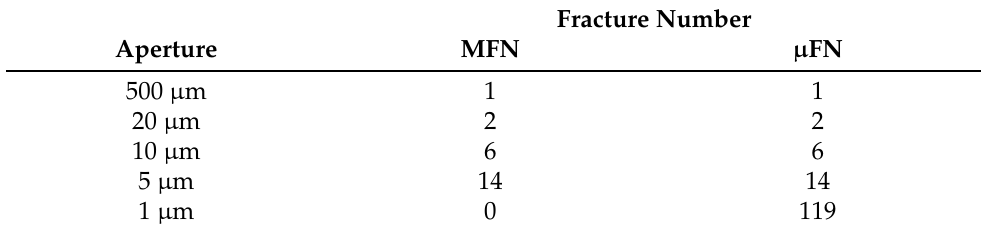
Figure 2. Two fracture networks are designed for this study: the MFN ( left ) contains fractures with apertures within 5–500 µ m and the µ FN ( right ) is characterized by the same backbone of the MFN with the addition of 119 1 µ m fractures. The circular markers on the rim of the fracture networks are inlet (red) and outlet (blue) ports. Table 1. Number of fractures contained in the MFN and µ FN